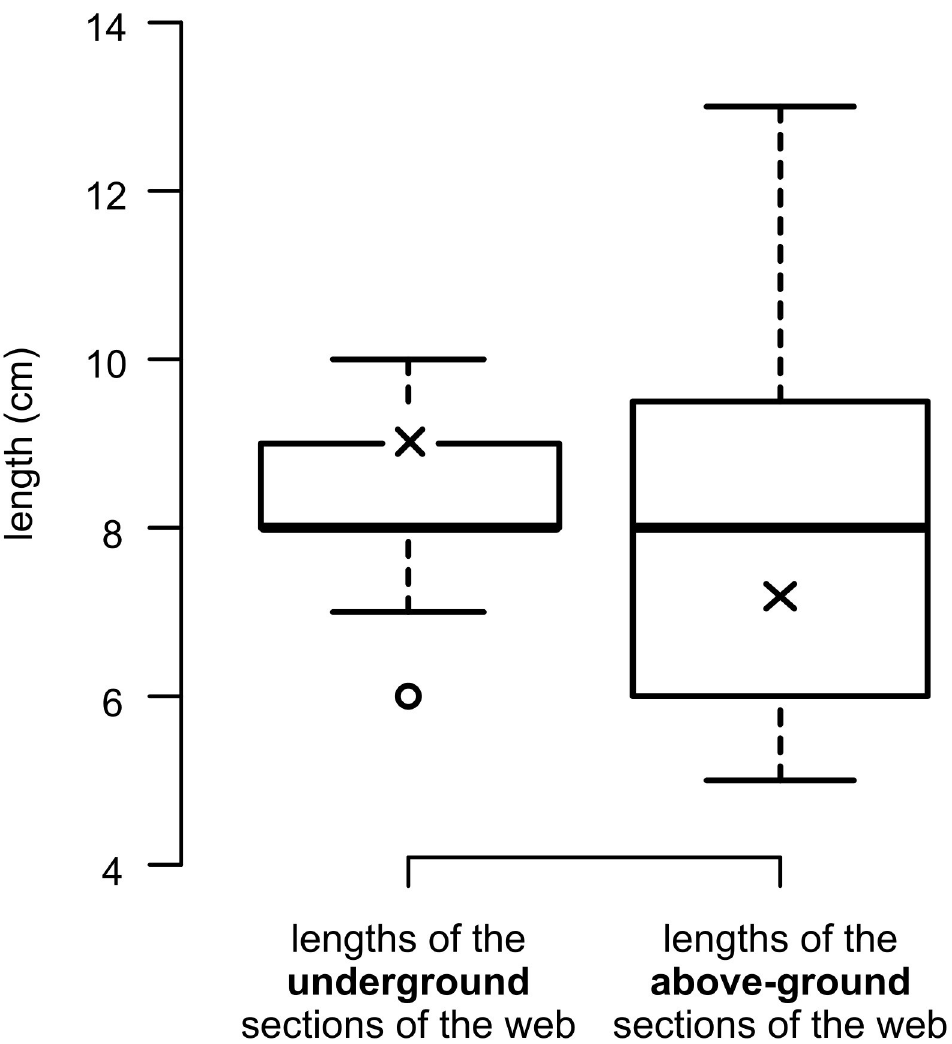
Fig 5. Boxplots showing the variation of the below-ground and above-ground lengths of excavated purse-webs of A . karschi , Pennsylvania, USA (n = 13). The means are indicated by an x and the hollow dot indicates an outlier (less than the 25th percentile minus 1.5 × Interquartile range).